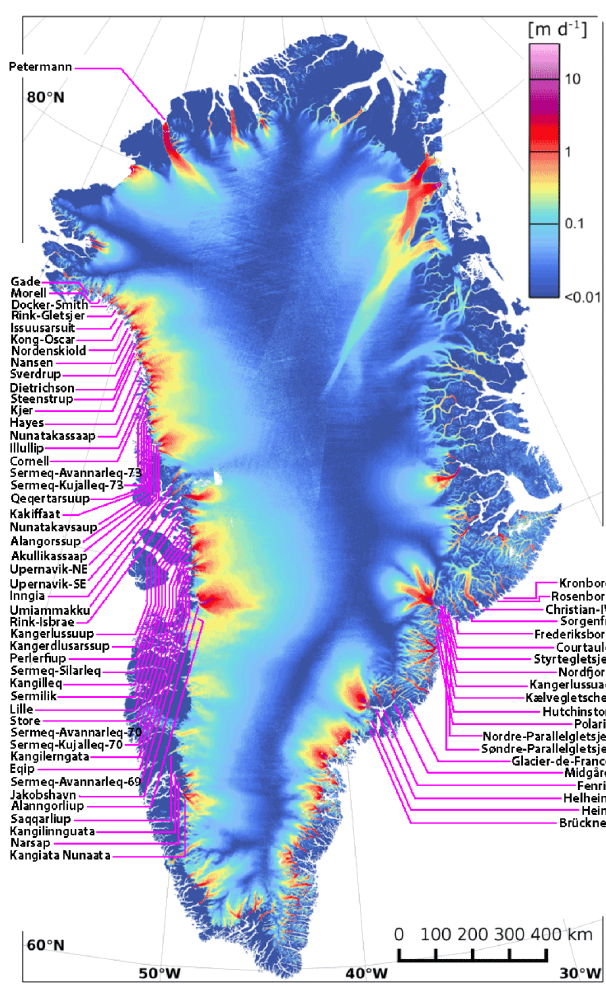
Figure 1. Spatial coverage map. Spatial distribution of 66 selected Greenlandic glaciers. The velocity map is taken from Nagler et al. (2015).